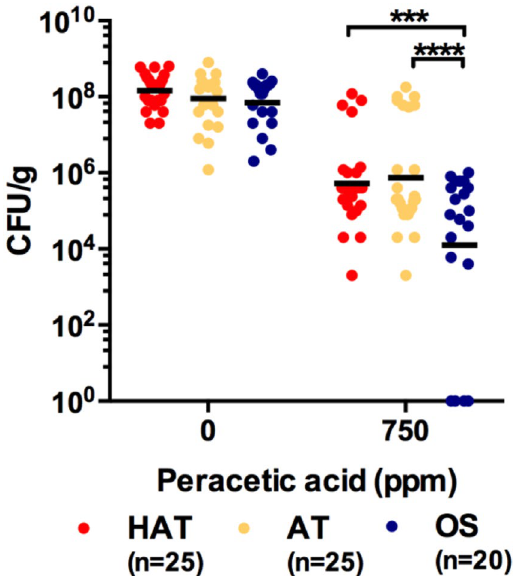
Figure 1. Tolerance to peracetic acid (PAA) in 70 C . jejuni isolates from retail chicken. Solid black bar indicates the mean CFU. The experiment was repeated three times and produced similar results. Two-way ANOVA was used to compare the results in the different aerotolerance groups. *** P < 0.005, **** P <